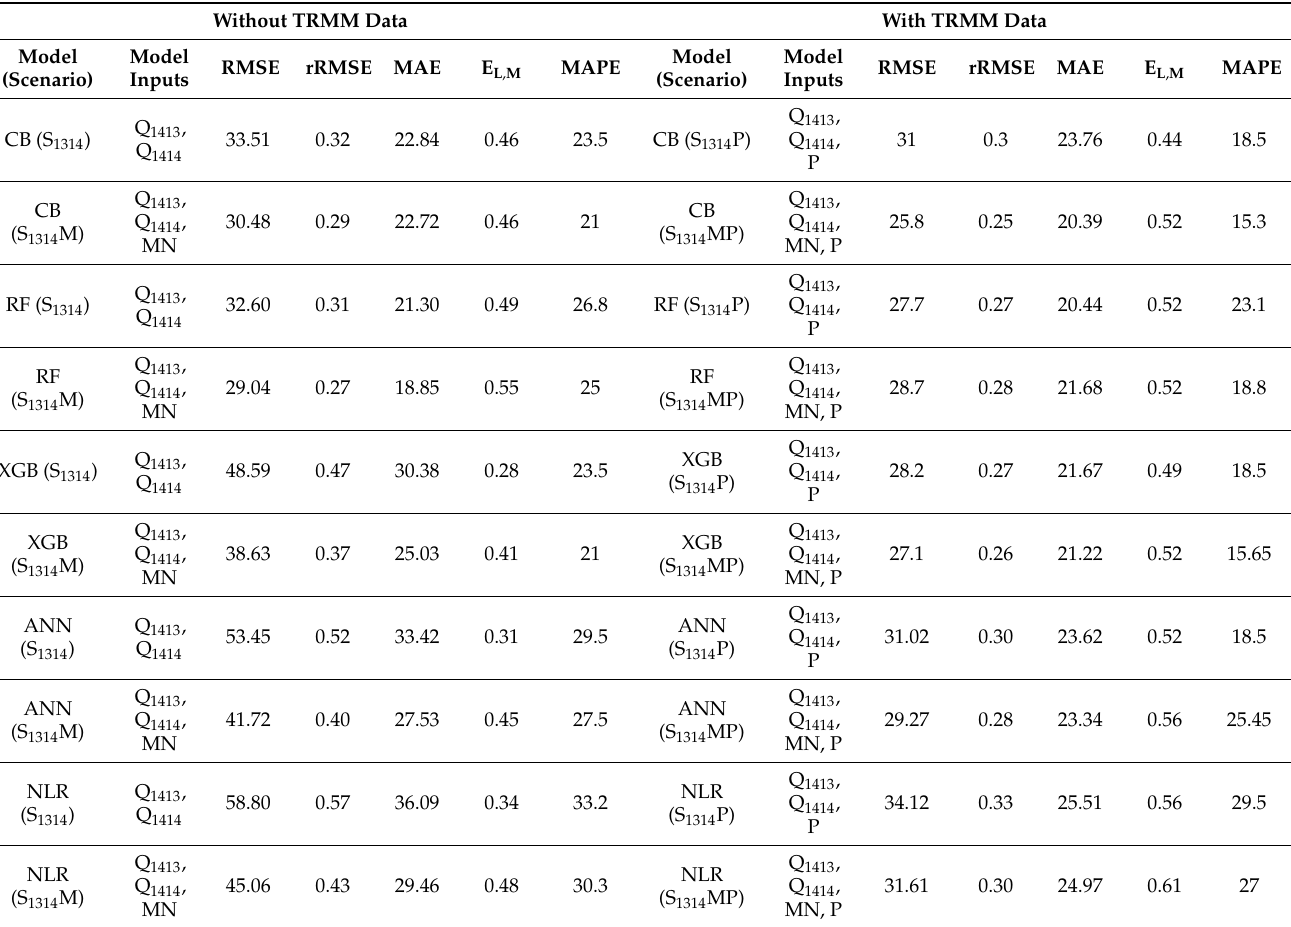
where Q 1402 is the current streamflow at the Kale Station (Code: 1402), Q 1414 is the current streamflow at Sutluce Station and Q 1413 is the current streamflow at the Durucasu Station. Table 5. Accuracies of the CB, RF, XGB, ANN and NLR methods in predictions of monthly streamflow at the Kale Station (Code:1402) using upstream data from the Durucasu (Code:1413) and Sutluce (Code: 1414) stations in the testing phase. With TRMM